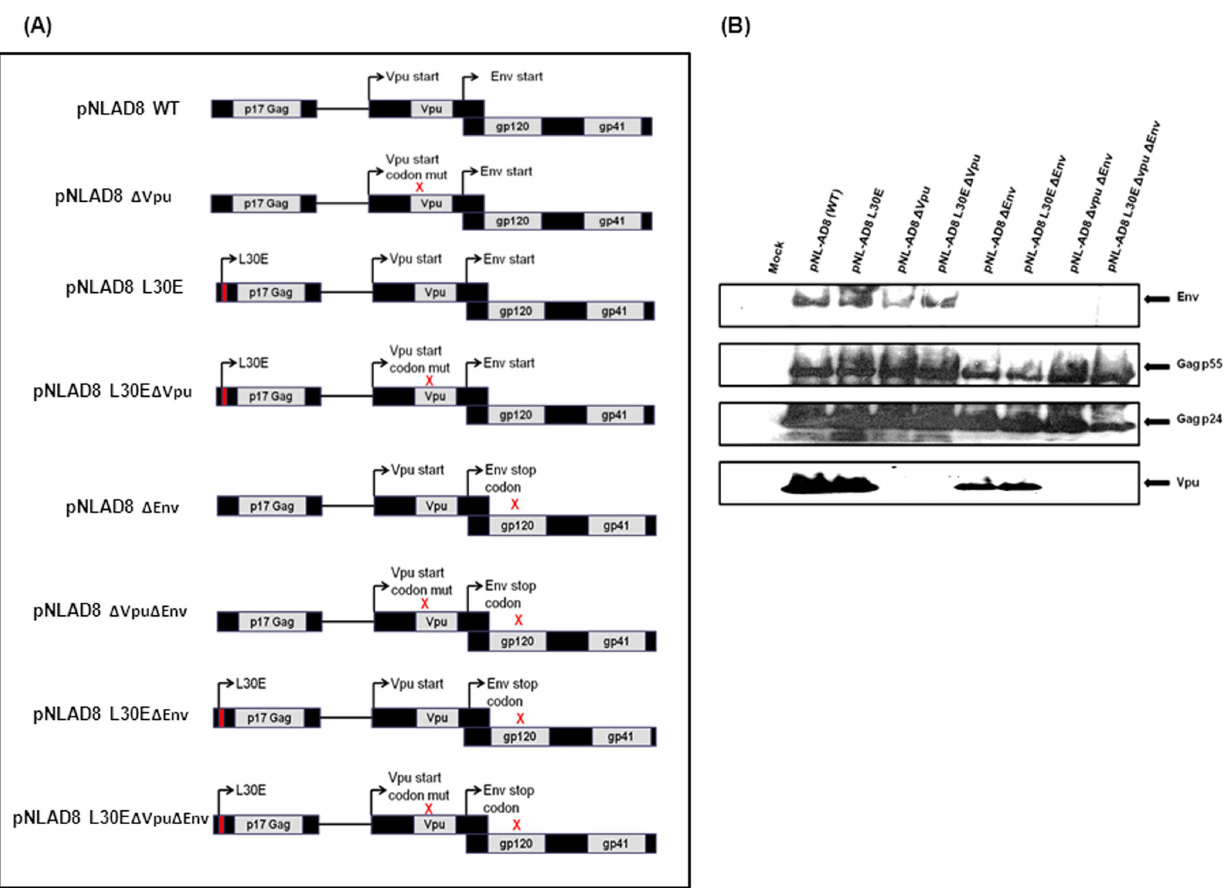
Figure 1. Construction of mutant clones. ( A ) Schematic representation of HIV-1 pNL-AD8 mutant clones used in the study. Diagram represent clones possessing Gag MA mutation (L30E), Vpu start codon mutation and HIV-1 pNL-AD8 Envelope deficient backbones possessing Gag MA (L30E) and Vpu start codon mutations. ( B ) Cell-associated viral gene expression of wild-type (WT), Gag and Vpu mutant clones and backbones carrying Env stop codon. 293T cells transfected with mutant plasmids were lyzed, cleared of cell-debris and nuclei by centrifugation and lysates were run in SDS- PAGE. Viral proteins were analyzed using anti-p24 (183-H12-5C), anti-gp41 (Chessie 8) antibody and anti-Vpu anti-serum. Note that substitution of ATG start codon of vpu with ATA abolished the expression of Vpu. Also, replacing Env start codon ATG with stop codon TAA abrogated the expression of pNL-AD8 Env. These Env deficient clones were further used in this study to make replication incompetent pseudotyped viruses from primary